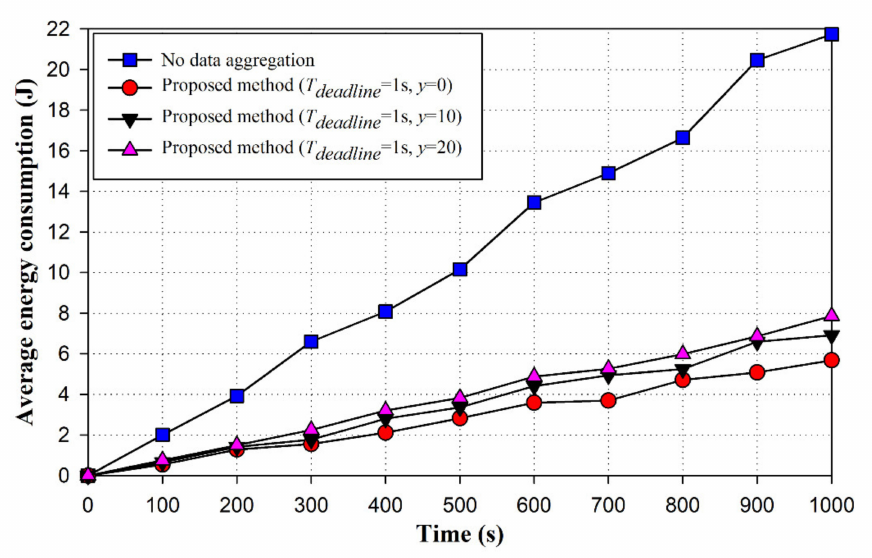
Figure 5. Average energy consumption with the deadline of 1